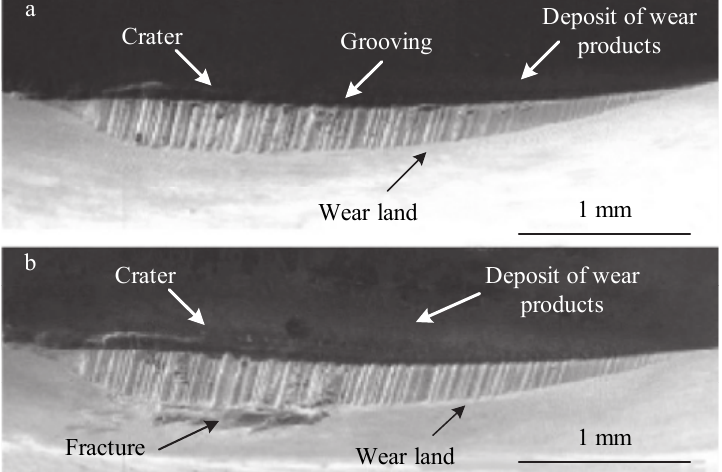
Figure 8. SEM micrographs of a worn CBN tool (( a ) v c = 250 m/min, f = 0.1 mm/rev; ( b ) v c = 350 m/min, f = 0.1 mm/rev)